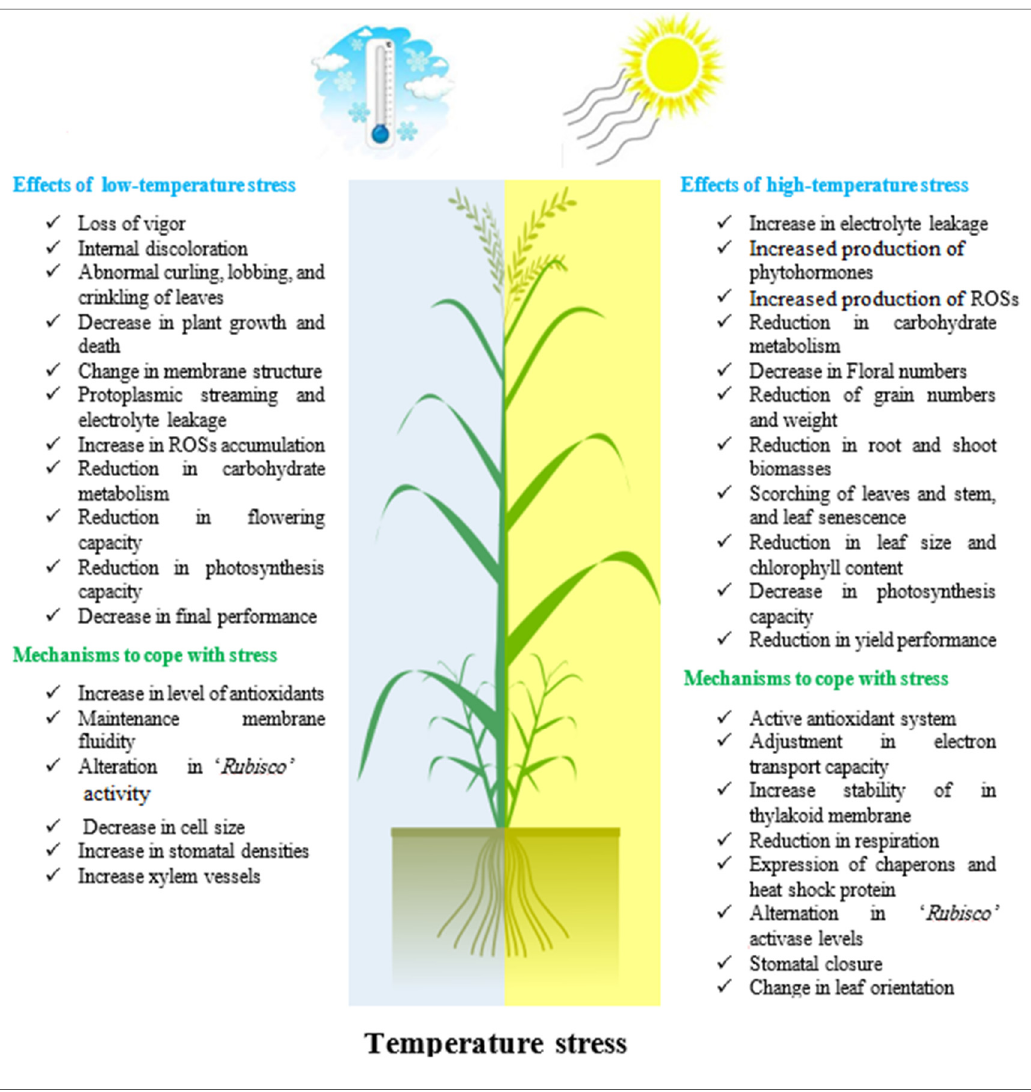
Figure 4. The effects of high- and low-temperature stress on the growth and productivity of plants.